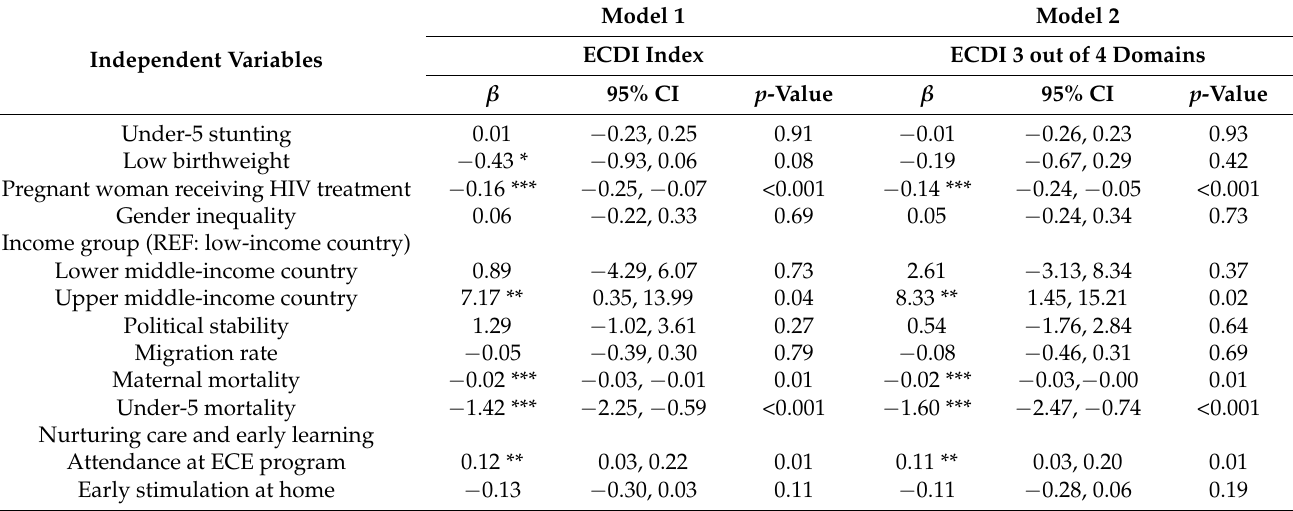
Figure 4. Descriptive results by country ( N = 68 LMICs). Note: Solid black lines show the linear fit between variables on the y- and x-axes. Table 4. Linear regression results ( N = 68 low- and middle-income countries